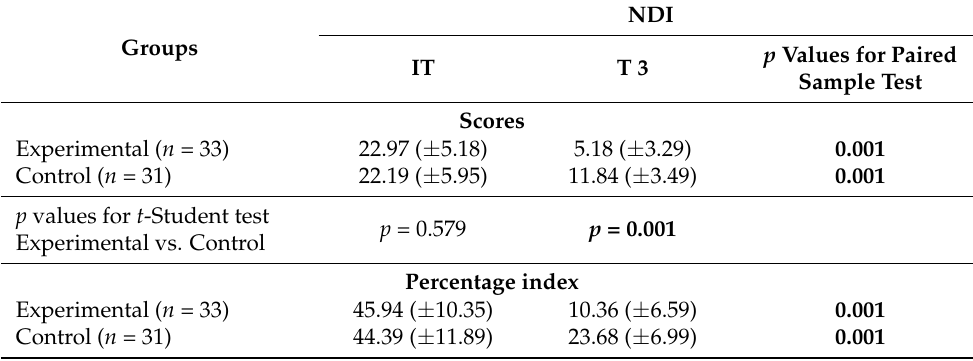
Table 7. Neck Disability